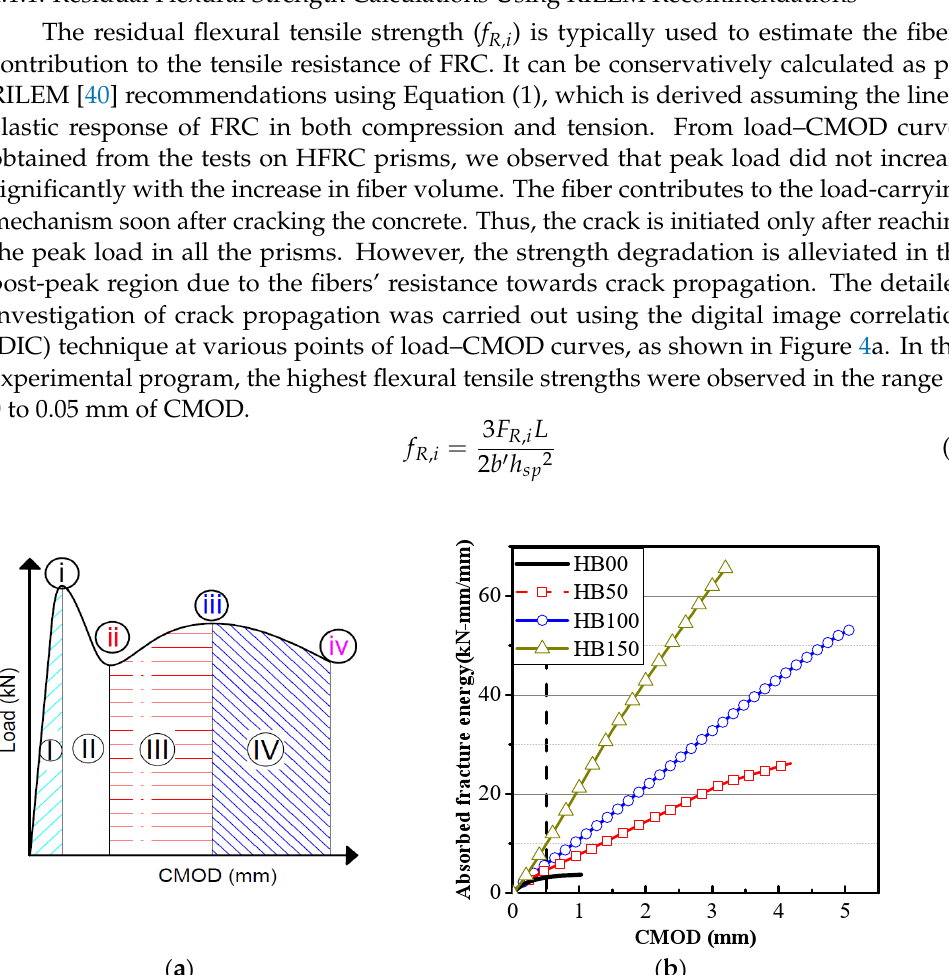
Figure 4. Fracture test results. ( a ) Schematic representation of considered points in load–CMOD curve. I = phases I, II = phases II, III = phases II, IV = phase IV, i = peak load, ii = fist load drop point, iii = second peak load due to fibers, iv = ultimate load point (CMOD = 3.5 mm). ( b ) Absorbed fracture energy of HB notched